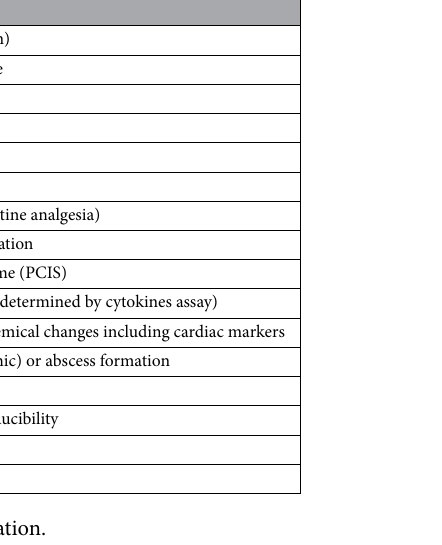
Table 1. Parameters included in safety